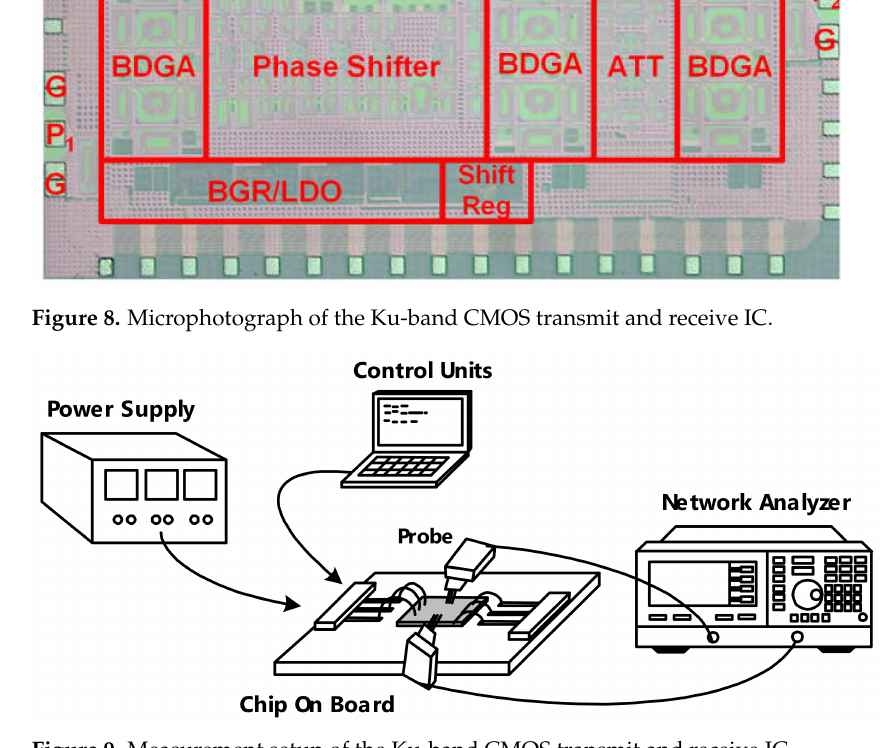
Figure 9. Measurement setup of the Ku-band CMOS transmit and receive IC.